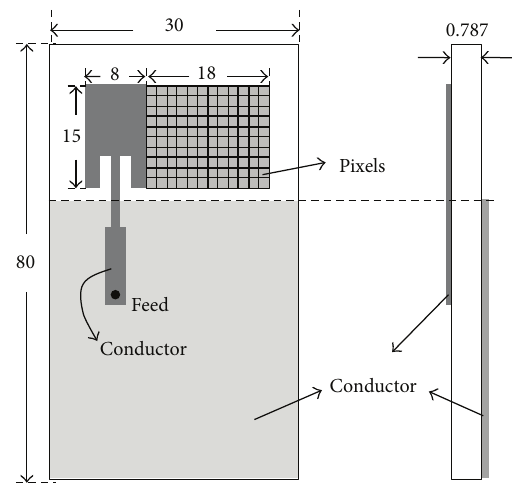
Figure 4: Geometry of the dual-band monopole antenna and the discretization of the design space (unit: